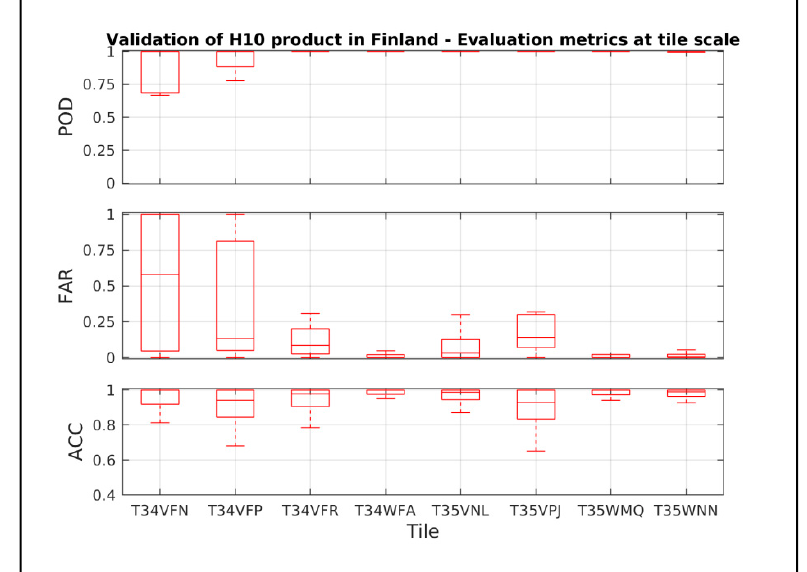
Figure 14. Evaluation metrics at tile scale in Finland.